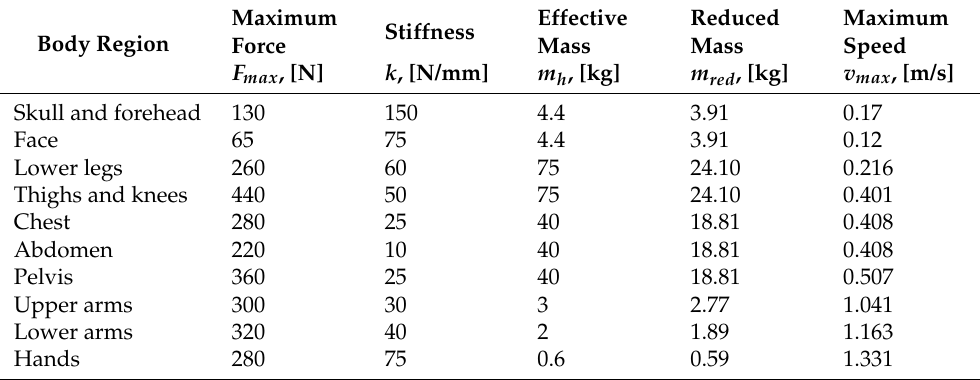
Table 3. Maximum admissible velocities according to the ISO/TS 15066:2016. Body